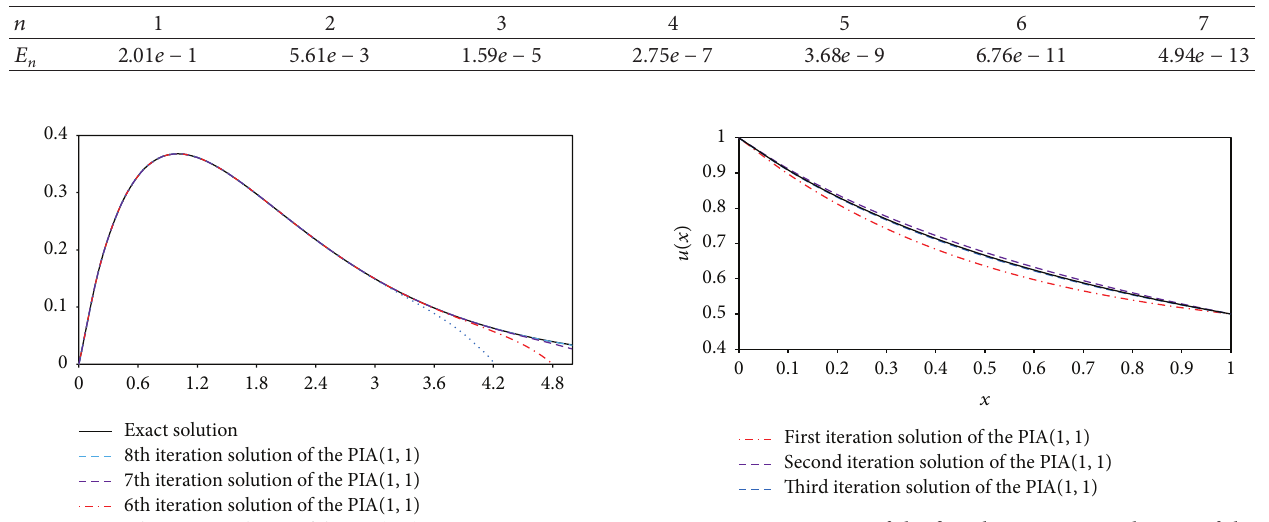
Figure 6: Comparison of the first three iteration solutions of the PIA (1, 1) method with the exact solution for example